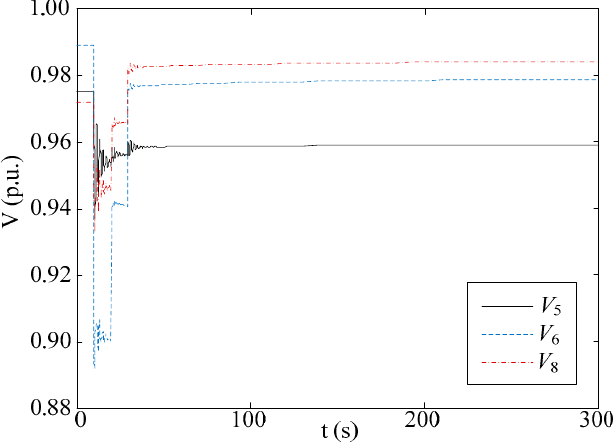
Figure 8. Voltage evolution using AH-MPC in case A. Table 1. The applicability judgment index I s m in case A.